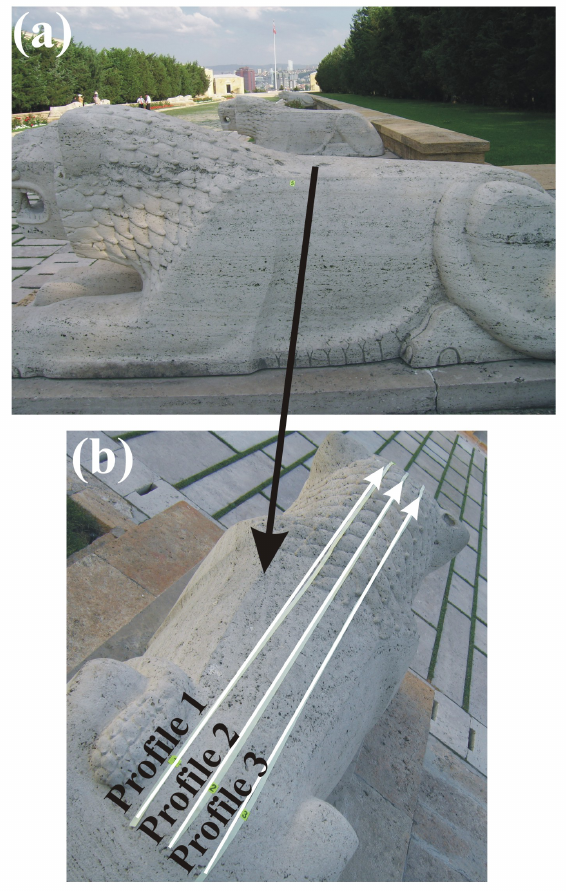
Fig. 6. Data acquisitions of the lions (a) the third lion and (b) three parallel profiles spaced 10cm on the back of the third